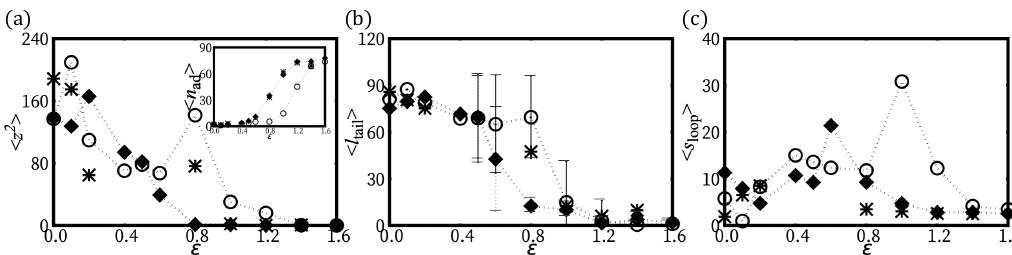
Figure 4. H-filaments adsorbed in a localized surface potential U ads . Various properties are measured for a H-filament of length S = 90 σ with one of its ends anchored at z = 0. Symbols ◦ and filled (cid:5) stand for the case of γ > 1 and γ < 1, respectively. WLCT case at strong/weak adsorption regimes are represented as ∗ . ( a ) (cid:104) z 2 (cid:105) at various strengths of surface potential (cid:101) . The inset shows the average number of the adsorbed monomers ( | z | < 0.2). ( b ) Average tail length (cid:104) l tail (cid:105) ; and ( c ) average loop length (cid:104) s loop (cid:105) at various (cid:101)